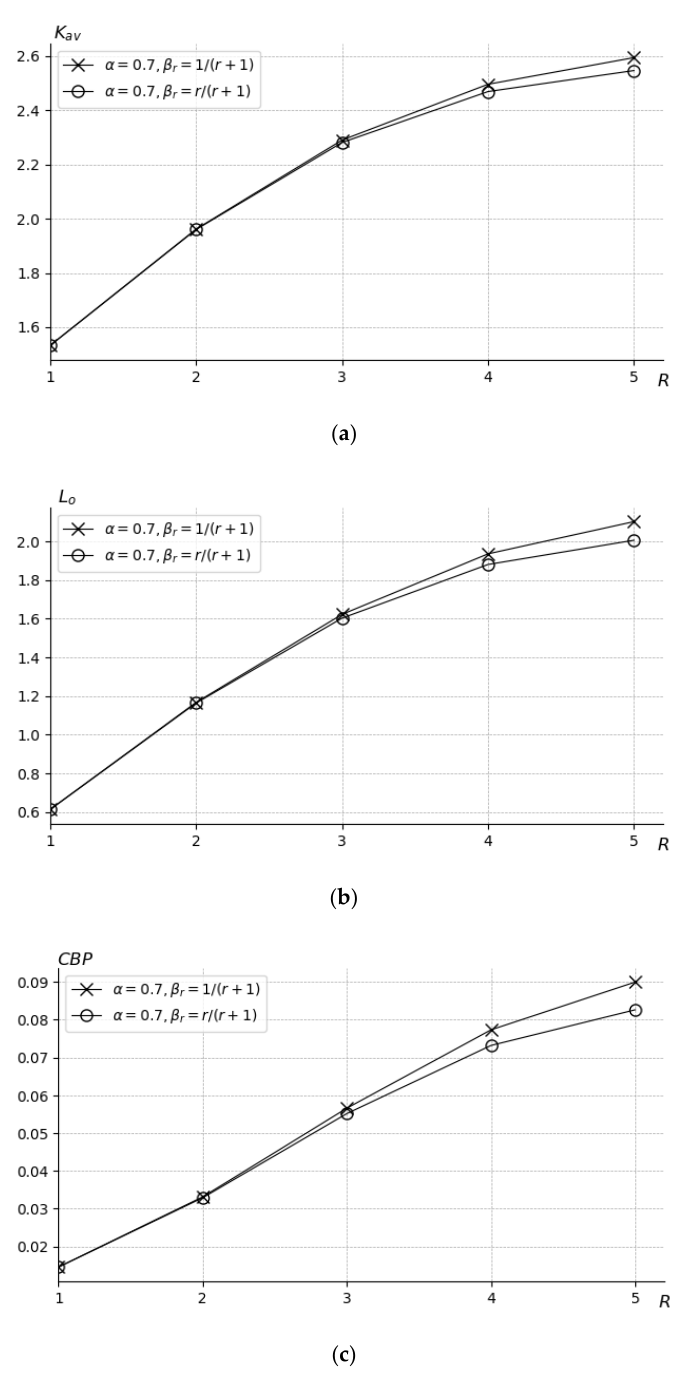
Figure 6. Dependency K av ( a ), L o ( b ) and CBP ( c ) on R for state-dependent retrial probabilities.